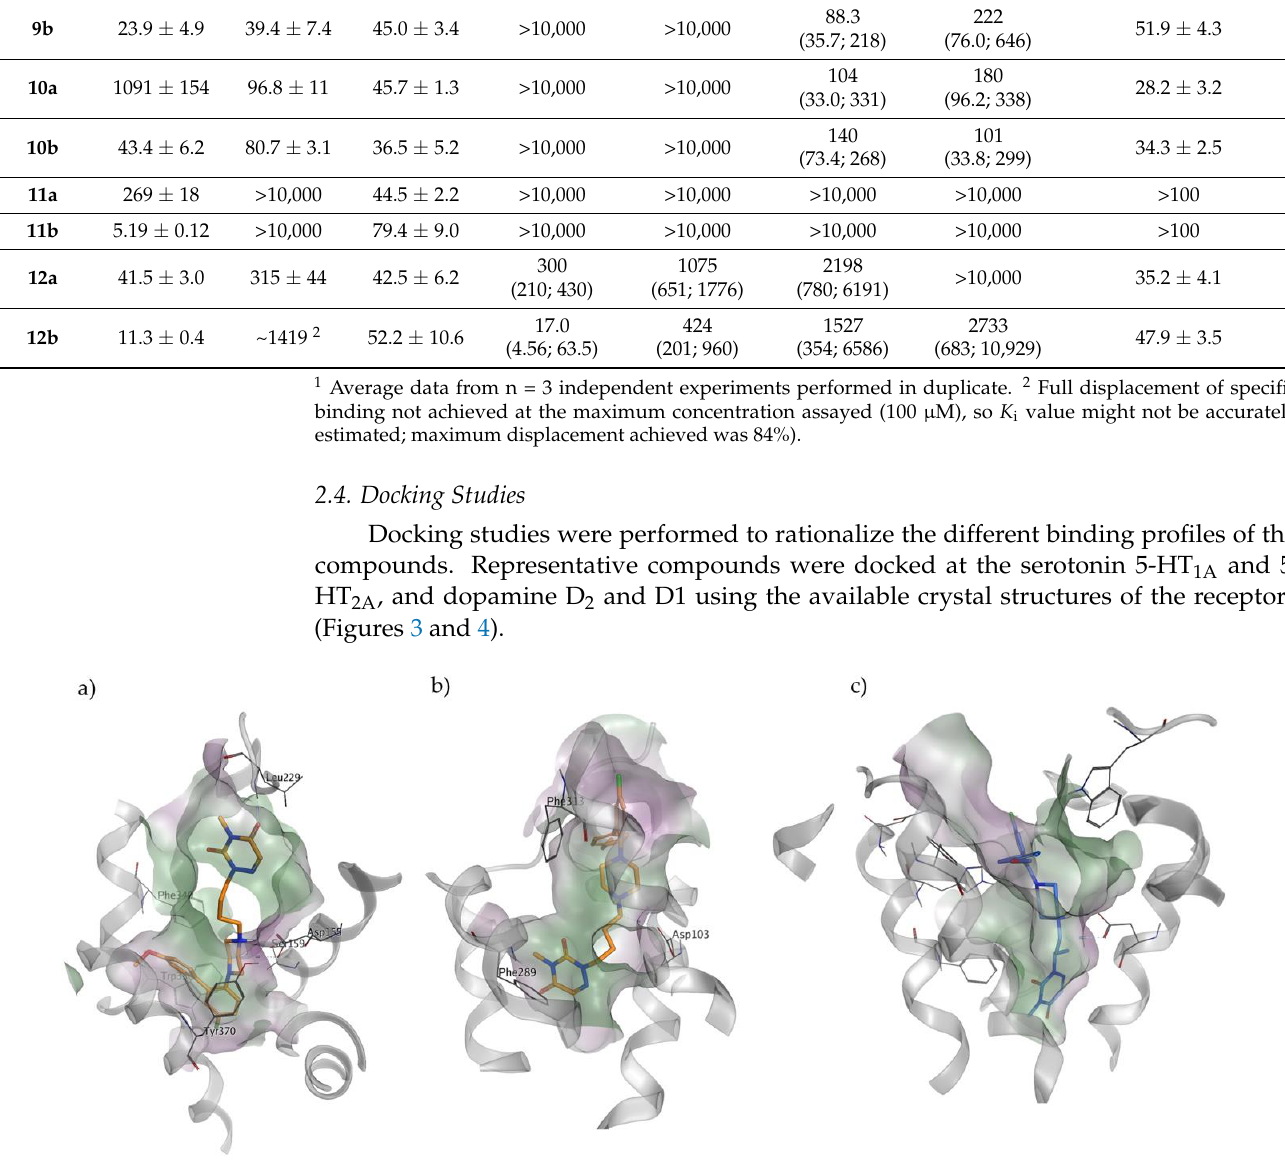
Figure 3. Docking poses of compound 9b at ( a ) serotonin 5-HT 2A receptor; ( b ) dopamine D 1 receptor; ( c ) dopamine D 2 receptor.